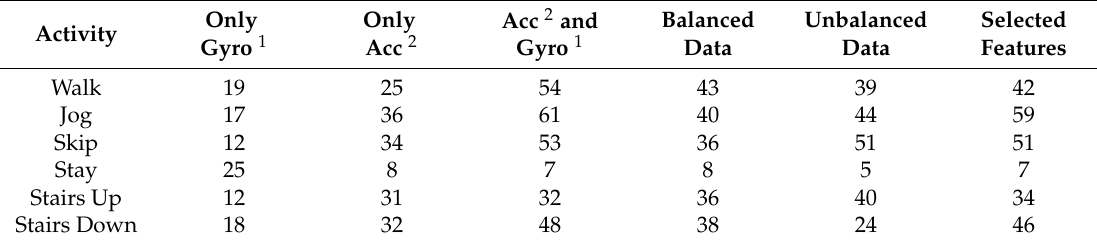
Table 5. The number of selected features according to different activity datasets and